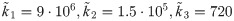
Comparison of stochastic simulation and Fokker-Planck-Equation.Stationary distributions obtained by stochastic simulation (histograms) and by solving the Fokker-Planck-Equation (lines) for different values of the burst size r (other parameters: k˜1=9·106,k˜2=1.5·105,k˜3=720). The dark dots indicate the fixed points of the deterministic model, which do not depend on r.